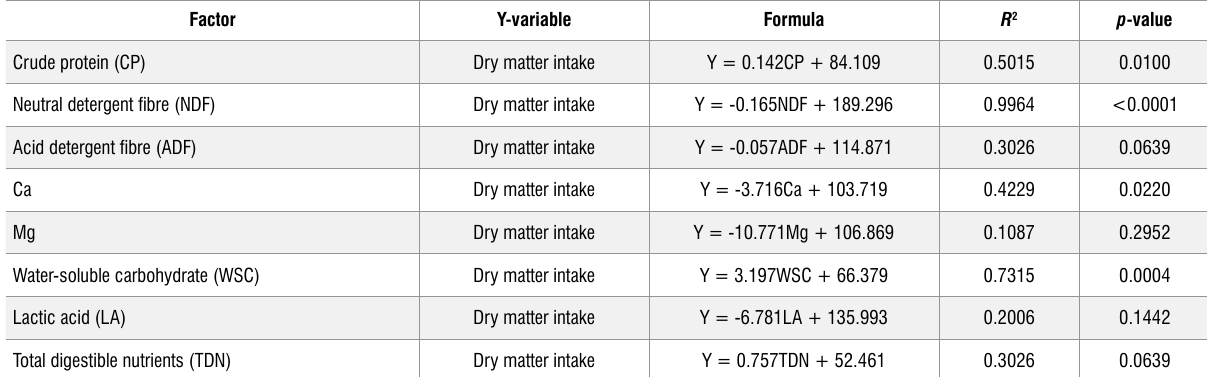
Regression equations predicting dry matter intake from chemical composition and fermentation+characteristics of silages Factor Y-variable